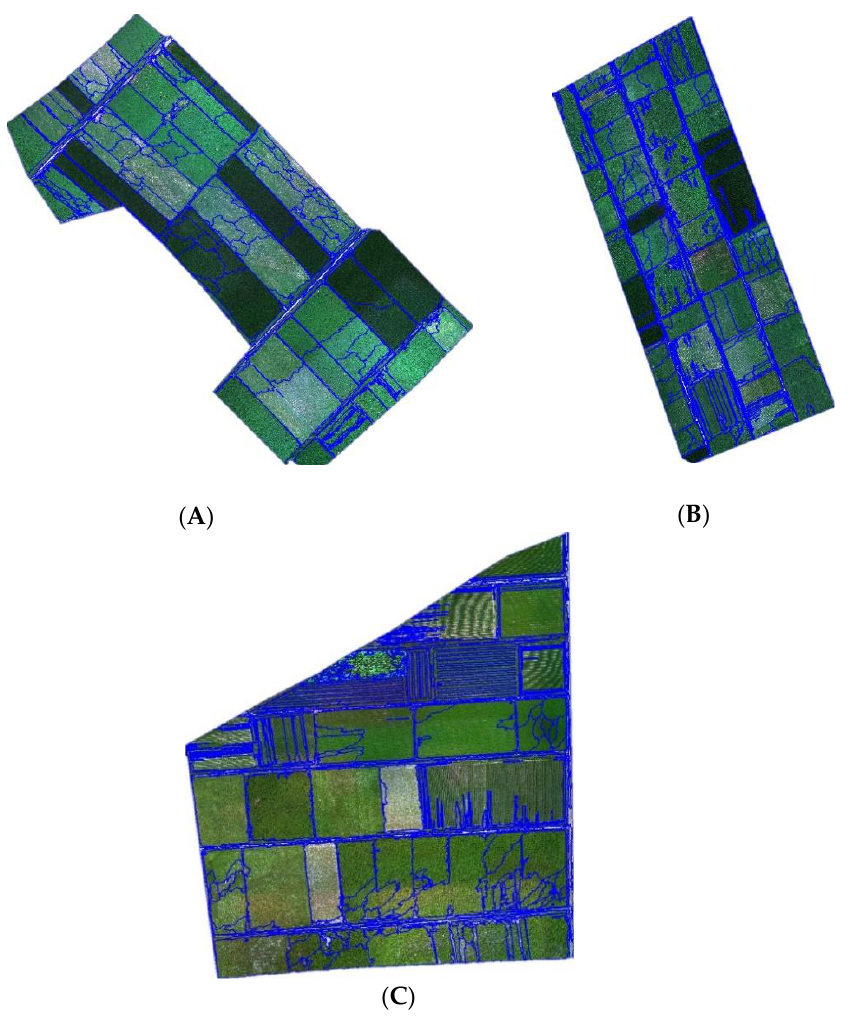
Figure 6. Image segmentation results of the study areas. (( A ) image segmentation result of study area 1; ( B ) image seg- mentation result of study area 2; ( C ) image segmentation result of study area 3.) area 1; ( B ) image segmentation result of study area 2; ( C ) image segmentation result of study area